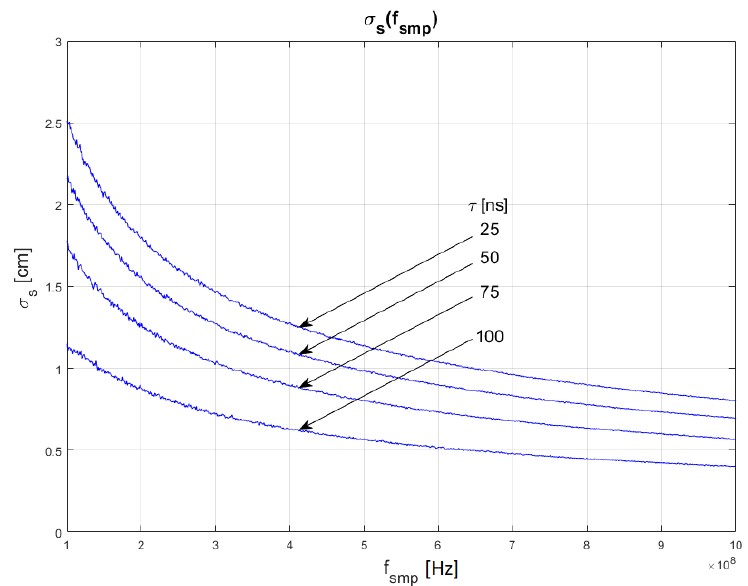
Figure 6. Dependence of measurement uncertainty on sampling frequency f smp . Parameters of generated pulses are shown in Table 2 Block 3.